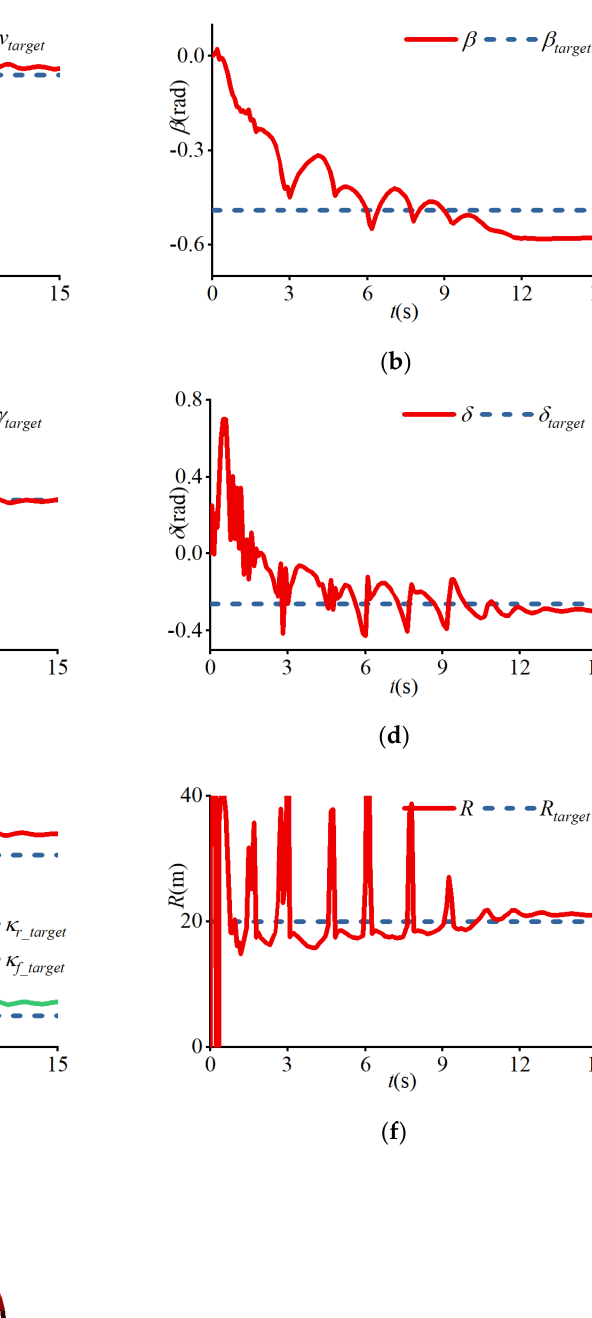
Figure 8. The simulation result with the 8.1 m/s original velocity and the target group (c): ( a ) the velocity; ( b ) the sideslip angle; ( c ) the yaw rate; ( d ) the steering angle; ( e ) the TYDEX longitudinal slip ratios of the front and rear tires; ( f ) the radius of the motion curve; ( g ) the motion curve of the vehicle. All continuous lines suggest the simulation results, while the dashed lines suggest the targets.